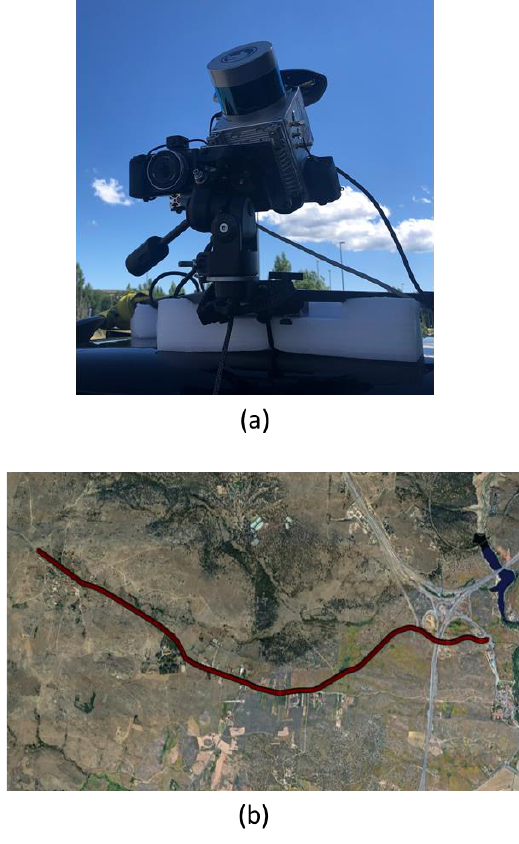
Figure 1. (a) Mobile Mapping system. (b) Trajectory of the case study, a 6-km long road section near Ávila